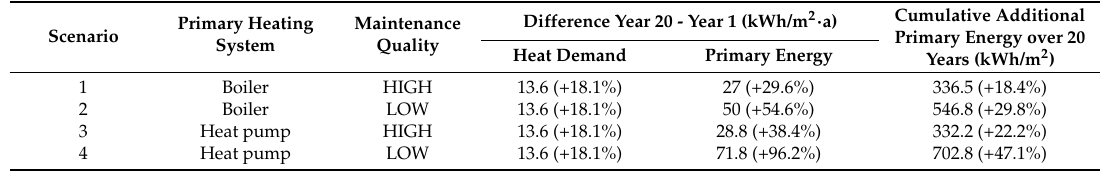
Table 8. Cumulative results for insulation and primary heating system degradation.